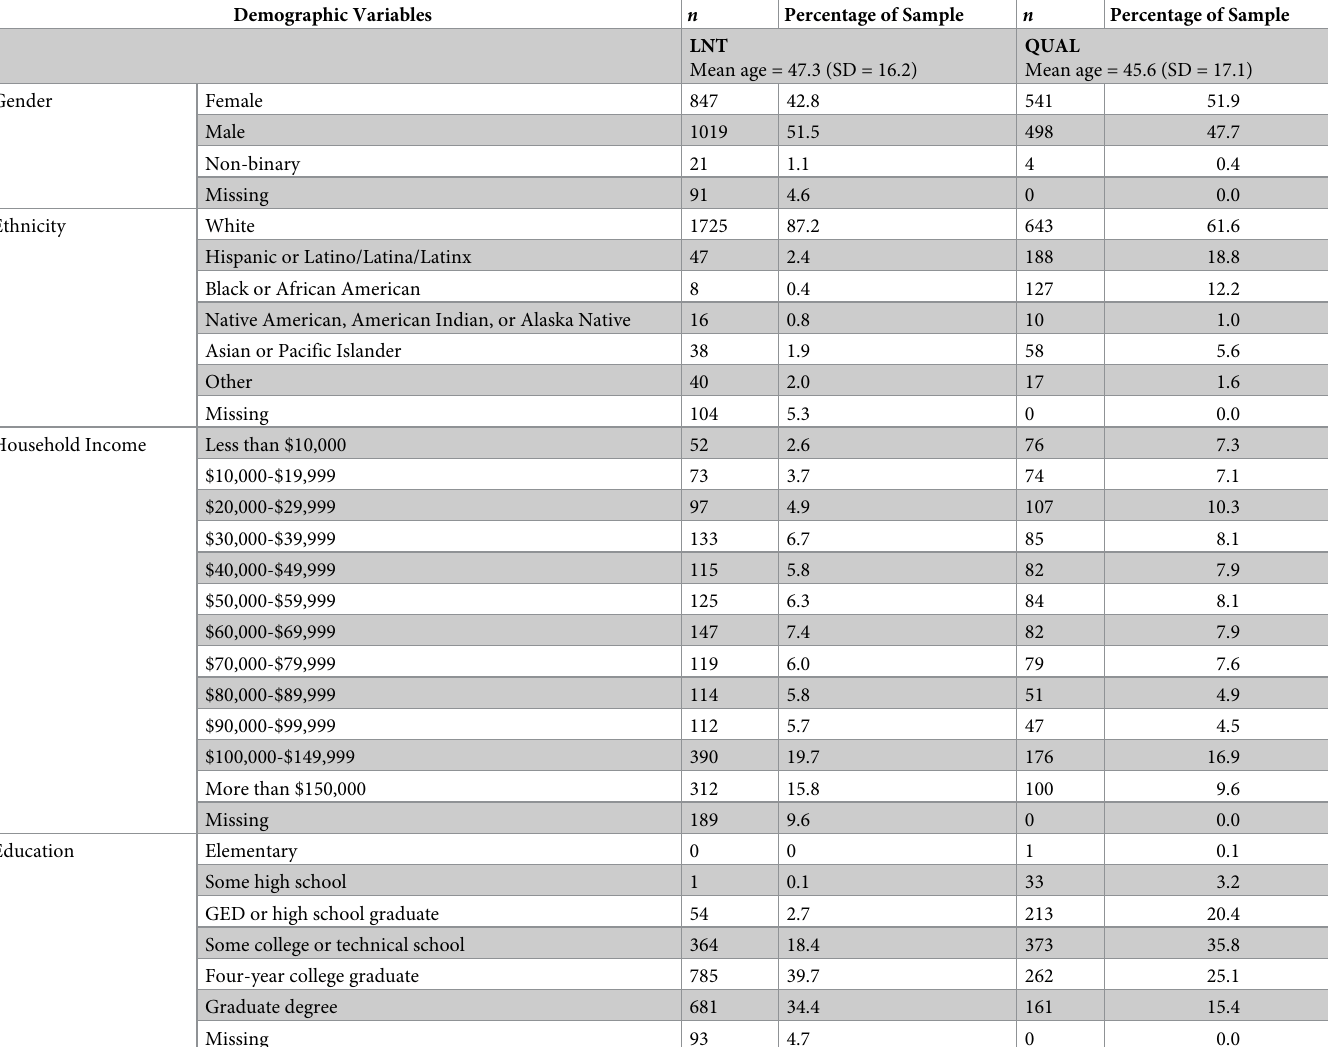
Table 2. Demographic characteristics of the two collected